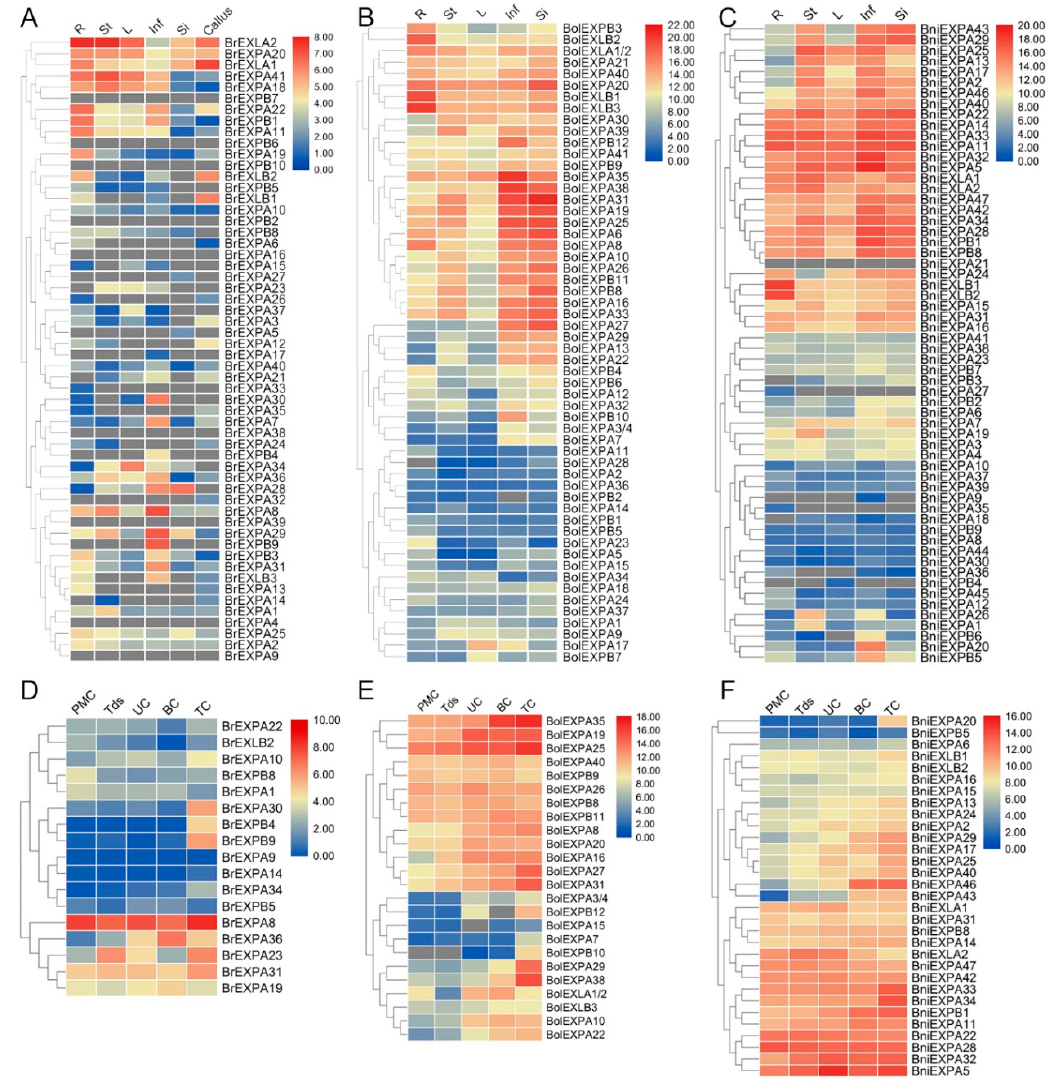
Figure 10. Hierarchical clustering and heat map generated by TBtools showing the expression levels of expansin genes in six or five tissues and different development stages of pollen in B. rapa ( A , D ), B. oleracea ( B , E ), and B. nigra ( C , F ). The scale bars represent relative expression level. The grey box designates undetectable expression. R roots, St stems, L leaves, Si siliques, Inf inflorescences, PMC pollen mother cell, Tds tetrads, UC uninuclear pollen, BC binucleate pollen, TC trinucleate pollen. Seventeen BrEXPs , 24 BolEXPs , and 31 BniEXPs had high expression levels in inflorescences and